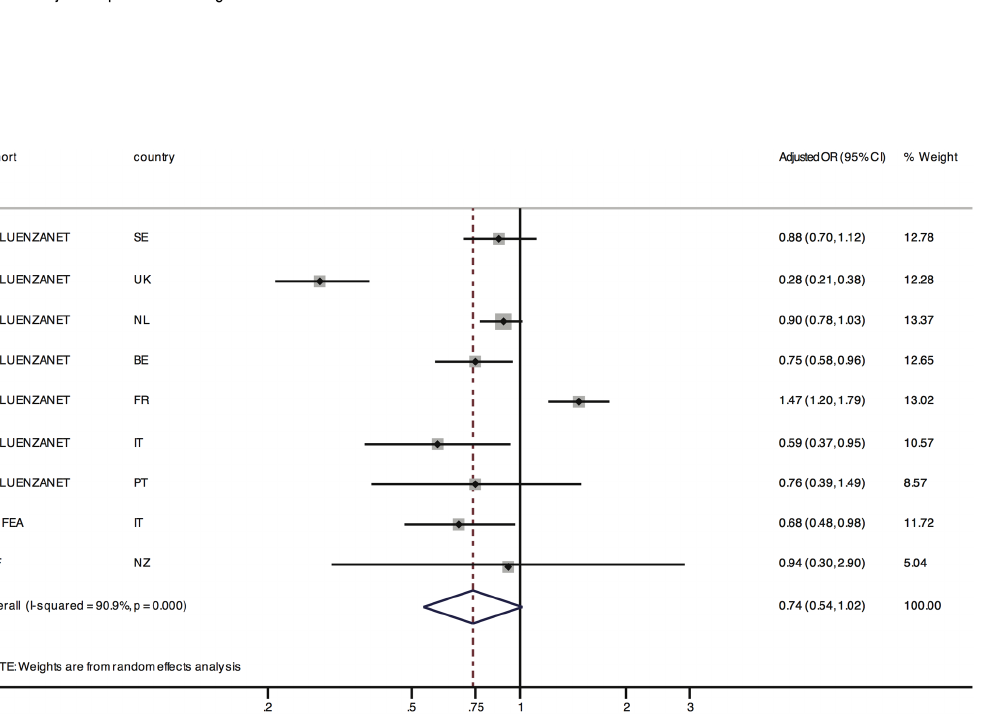
Fig. 2. Summary of the results reported in Table 2. The effect of online recruitment on follow-up participation compared to offline recruitment is shown. Given that the studies are highly heterogeneous by design and target different populations, the pooled estimate should be considered as an average of the study-specific effects rather than as a causal